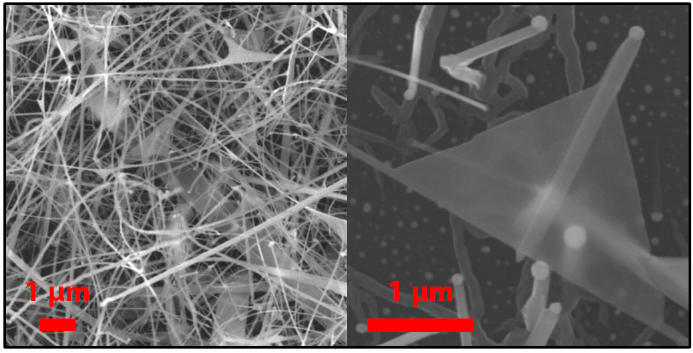
Figure 1. Gallium Oxide nanowires grown at 30 cm from evaporating source ( left ) and a detail of a nanoplateaux ( right